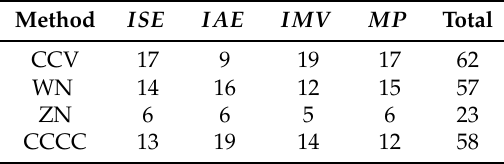
Table 9. Total scores for disturbance rejection for the set P 4 .